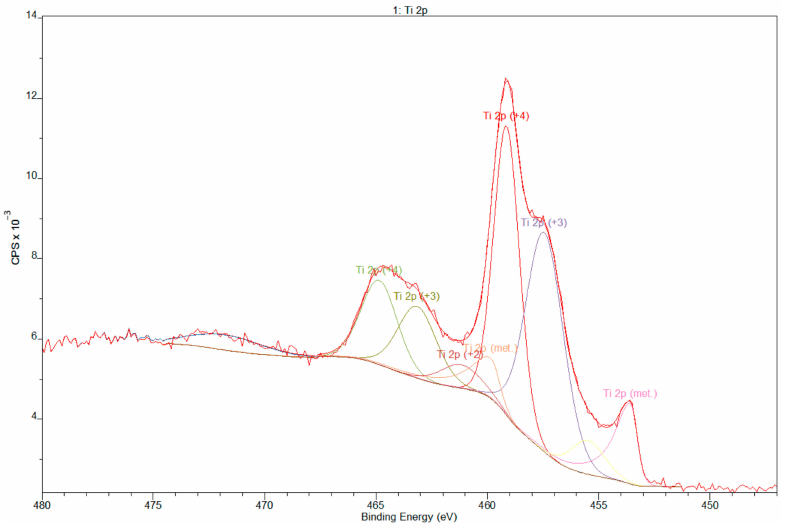
Figure 5. Deconvolution XPS spectra of